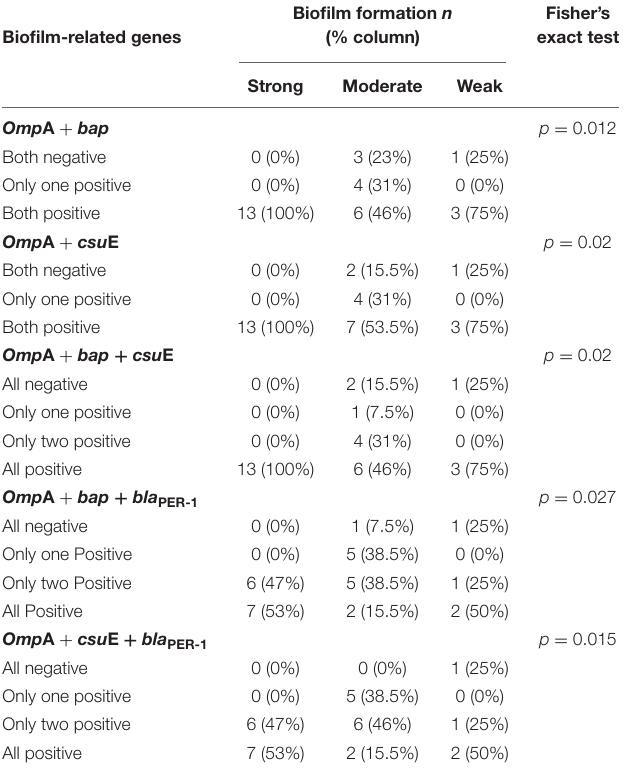
TABLE 4 | Genotype–phenotype associations of biofilm-related genes with biofilm formation.